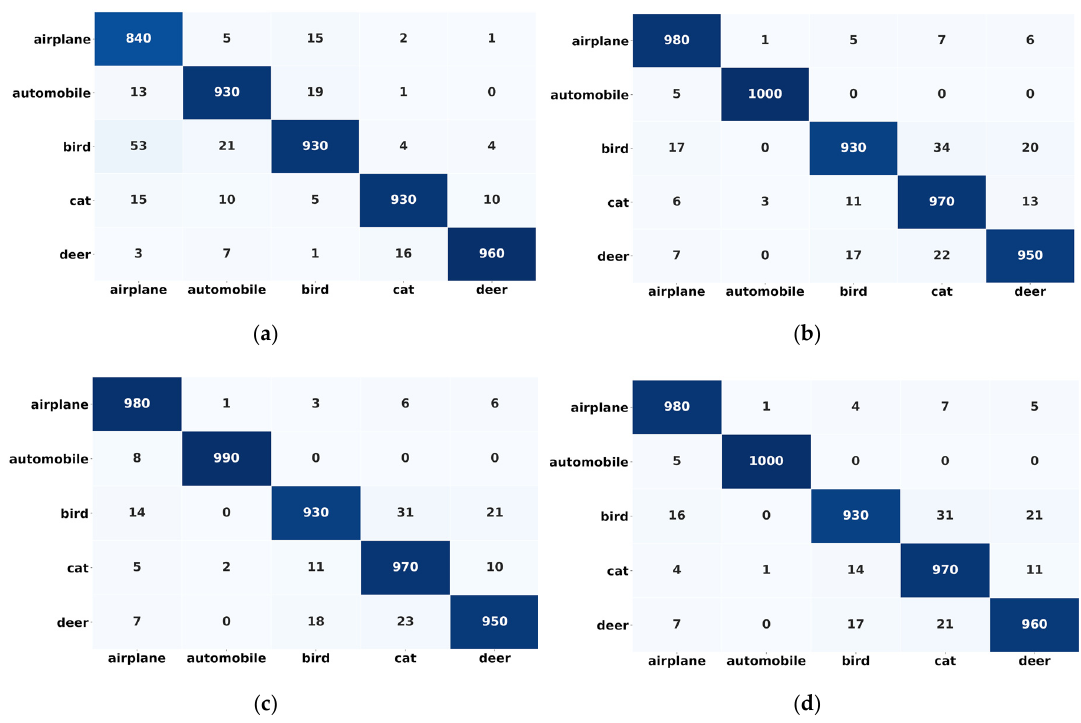
Proposed Framework Table 6. Comparative analysis of the proposed framework and state-of-the-art models. Accuracy ( % )